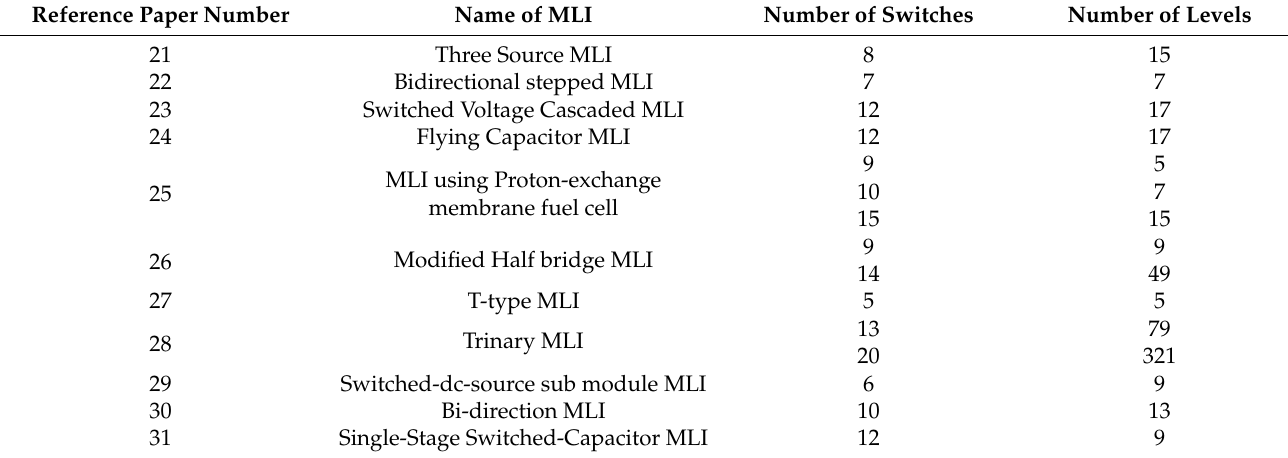
Table 2. Number of switches versus Number of